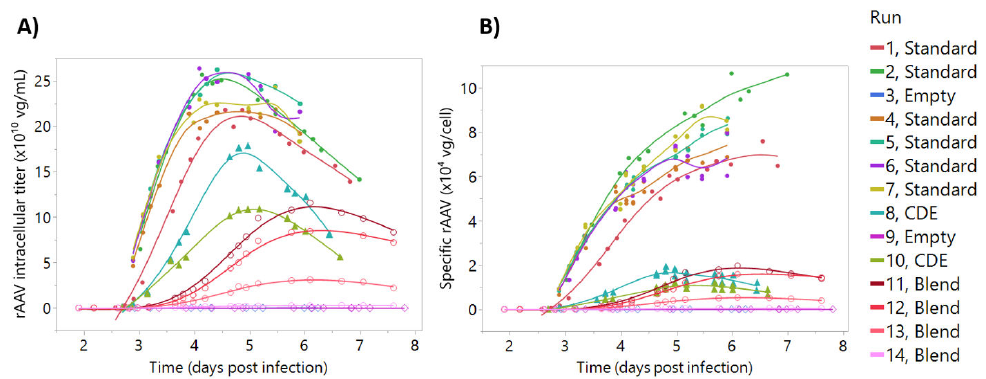
Figure 6. Recombinant adeno-associated virus (rAAV) intracellular production profiles. The datapoints represent vector genome quantification. Filled circles represent “standard” batches, triangles represent “cell density e ff ect” batches, empty diamonds represent “empty batches”, and the empty circles represent “blend batches”. For the details on batch nomenclature, the reader is referred to Figure 1. Lines represent a smooth of the reference data, unrelated with model predictions. ( A ) rAAV intracellular titer, the rAAV concentration after lysing pellet from 10 mL of culture. ( B ) Specific rAAV titer. Same data as ( A ) normalized by the number of viable cells at the corresponding sampling